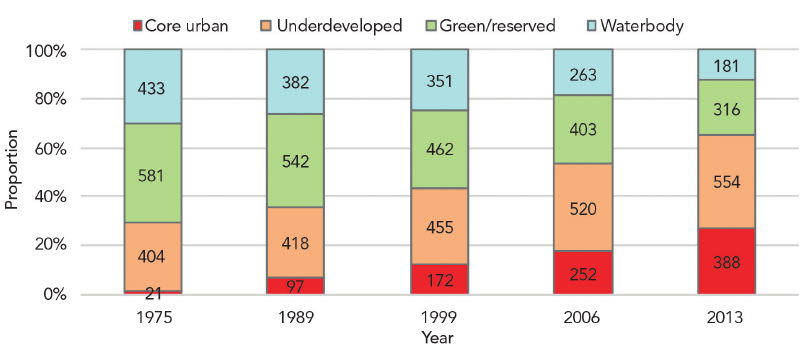
Table 2: Observed land-cover change rate over the periods